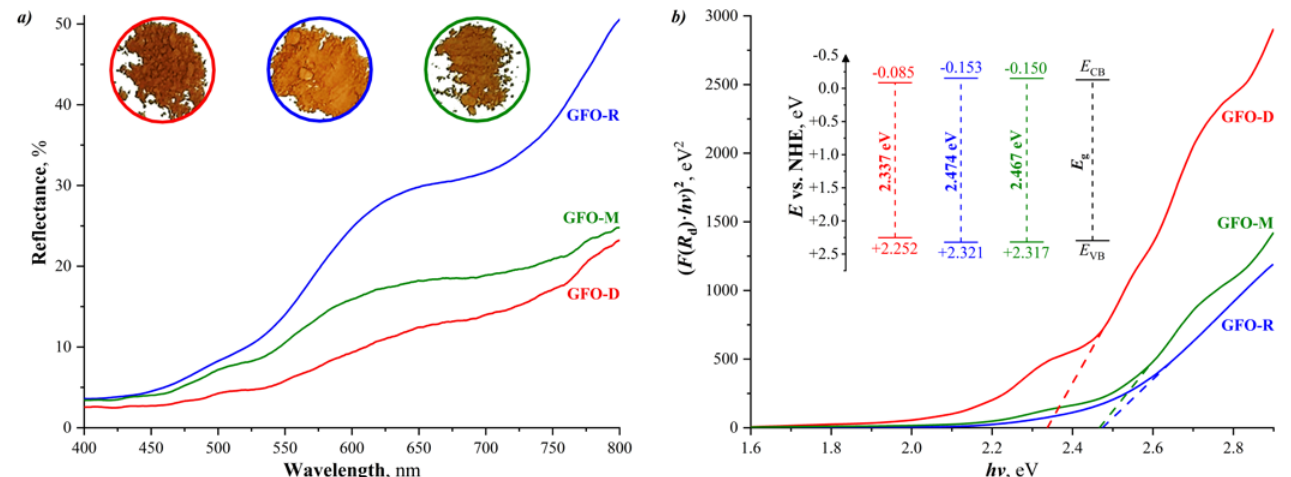
Figure 7. ( a ) DRS spectra of the obtained samples of GdFeO 3 nanocrystals. The insets show photographs of the powders obtained after the heat treatment of the co-precipitated hydroxides; ( b ) Tauc plots for direct allowed transitions of the obtained samples of GdFeO 3 nanocrystals. The inset shows the bandgap values and the potentials of the conduction band ( E CB ) and the valence band ( E VB ) of these nanocrystals: E = potential versus the normal hydrogen electrode (NHE).